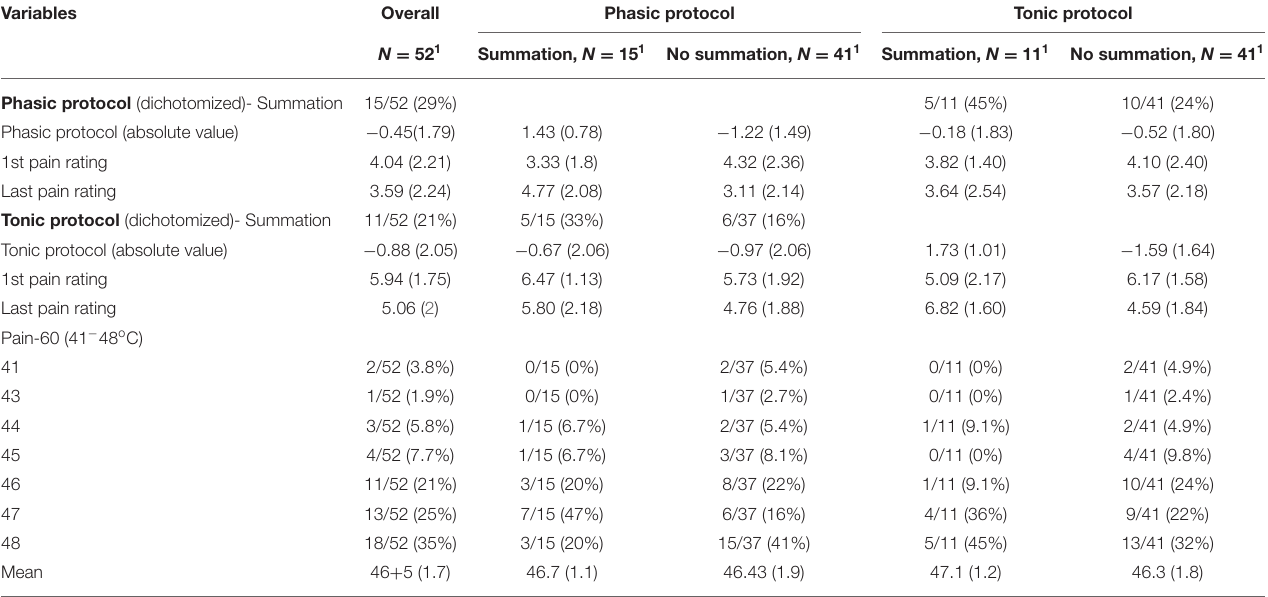
TABLE 2 | Temporal summation characteristics of the sample.